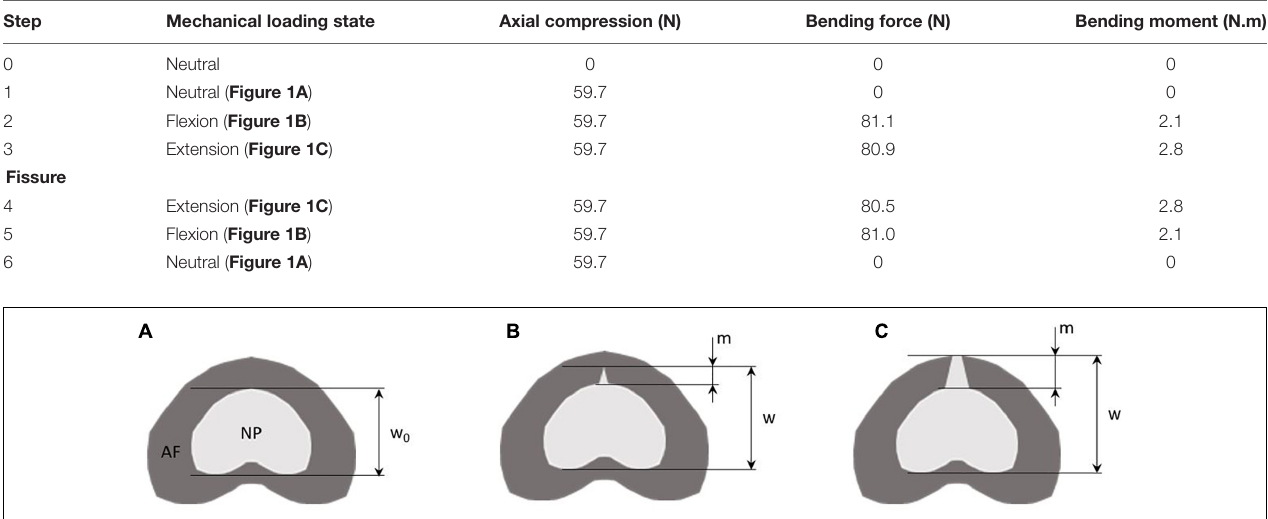
FIGURE 2 | Method to calculate the nucleus sagittal boundary displacement (w), the degree of nucleus pulposus (NP) migration (m) within the annulus fibrosus (AF), and the nucleus sagittal strain for each mechanical step. Panel (A) is the reference mechanical loading state, i.e., step 1, panel (B) is a mechanical state with partial migration of the annulus m < 50% of the total annulus thickness, panel (C) is a mechanical state at total migration of the annulus m > 50% of the total annulus thickness. Nucleus sagittal boundary displacement is calculated for each mechanical state by w – w 0 . Nucleus sagittal strain is calculated for each mechanical state by (w – w 0 )/w 0 . Migration m is calculated from the proportion of nucleus displacement within the